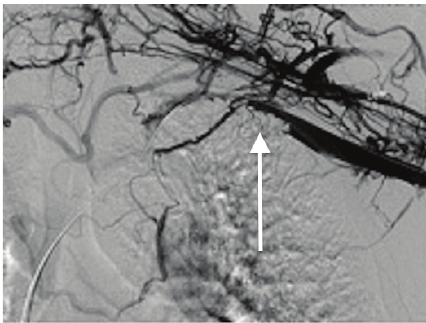
Figure 1: Venogram of Left subclavian vein demonstrating throm- bus extending into the left brachiocephalic vein.